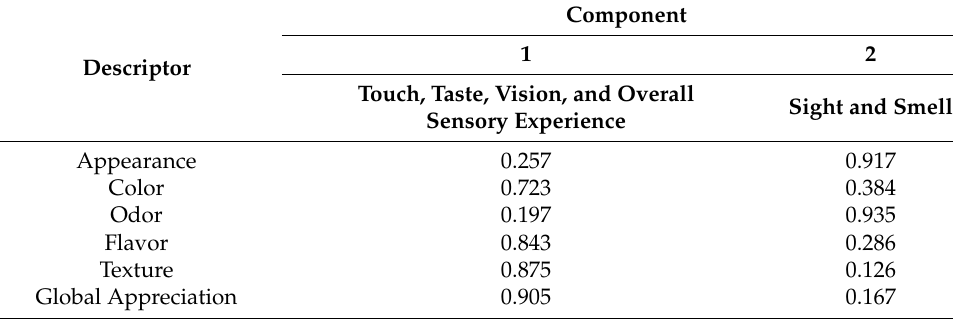
Figure 9. Behavior of comber pastry descriptors, according to consumer classifications. Table 8. Rotated component matrix for each comber pastry descriptor.